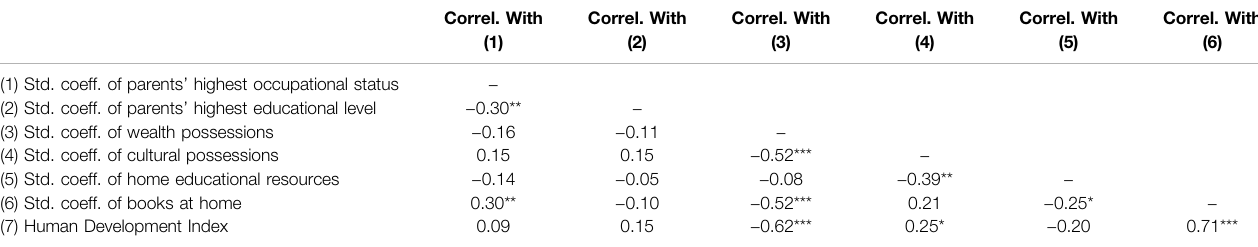
TABLE4| Mean(SD)Pearsoncorrelationsamongthestandardizedcoef fi cients(averaged acrossacademicdomains)ofsixSEScomponentsandtheHumanDevelopment Index in 77 societies. Correl. With